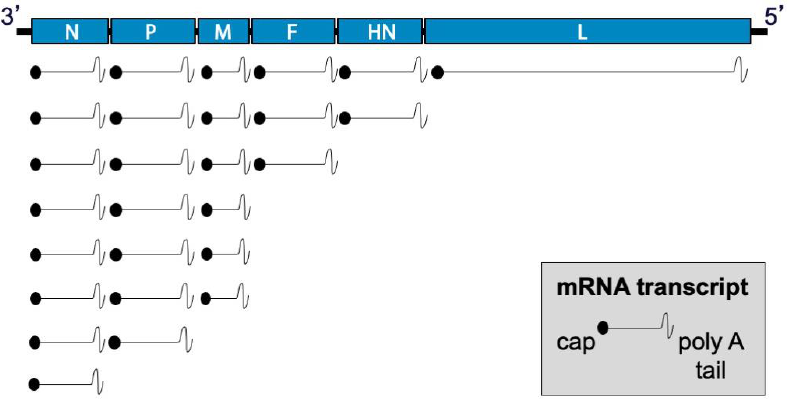
Figure 4. Differential transcription of SeV genes. Transcription begins at the 3 (cid:48) end of the genome with the N gene. At each gene junction, the polymerase may continue to transcribe downstream genes or terminate transcription. Transcription start sequences vary between genes with the sequence upstream of the F gene resulting in the highest level of termination. As a result, the relative expression levels of F, HN, and L genes are substantially less than those of the upstream genes. Insertion of a foreign gene adds another gene junction and usually alters the ratio of gene transcripts in addition to decreasing the abundance of downstream transcripts. Positioning of foreign genes near the 3 (cid:48) end of the genome causes greater virus attenuation than positioning foreign genes nearer the 5 (cid:48)